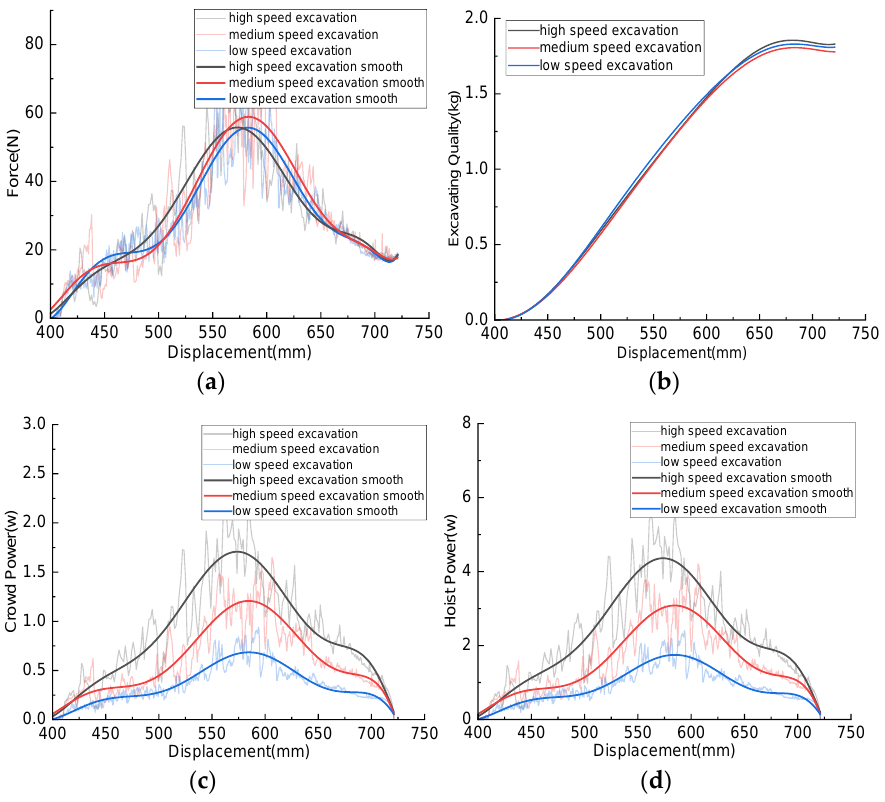
Figure 11. Comparison of simulation results under different speed combinations: ( a ) Excavating resistance; ( b ) Excavating quality; ( c ) Crowd power; ( d ) Hoist power.